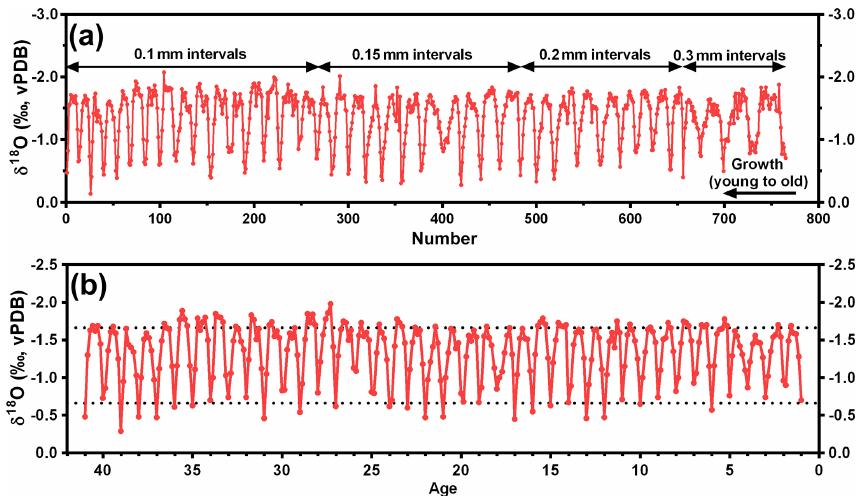
Figure 2. (a) The δ 18 O profiles of A5. (b) The δ 18 O A5 profiles chronology scale after resampling the data; the dotted lines indicate the average annual maximum and minimum.